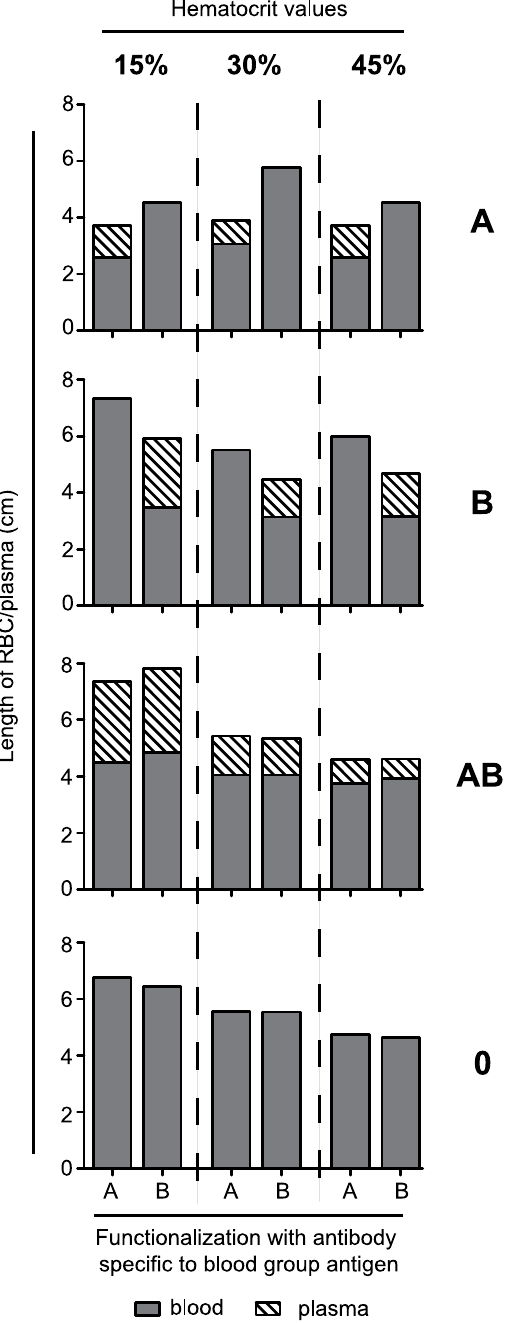
Figure 5. Effect of various hematocrit values on blood group determination. The hematocrit of blood was artificially set to the three indicated value in case of blood samples from the four different blood groups (A, B, AB, 0) then tested in microfluidic channel system where the two arms were functionalized by anti-A or anti-B group antibodies. The length of RBC and separated plasma regions are indicated by grey or striped columns. Graph shows representative results from three